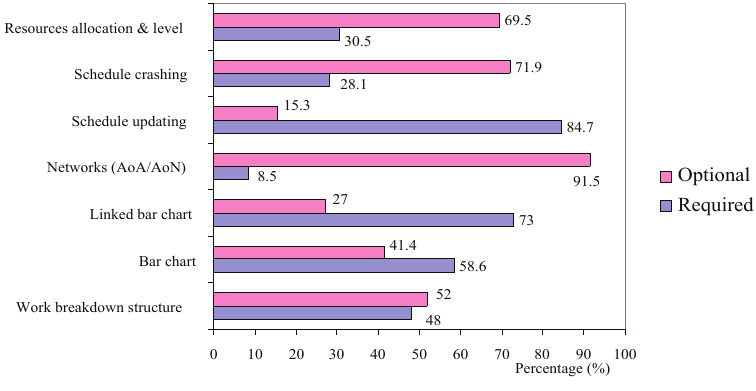
Figure 4: Necessity of time tools (contractors’ perspective)